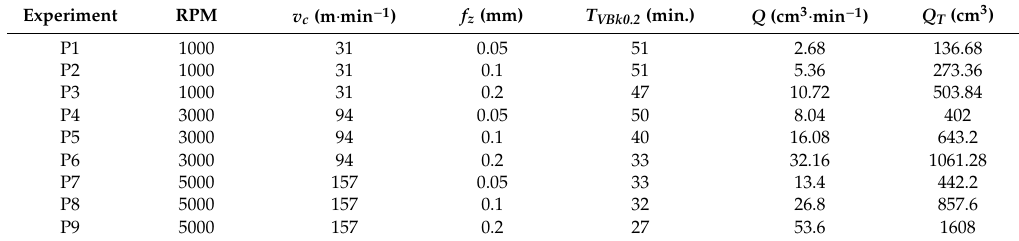
Table 5. Tool life T VBk20 and material removal rate Q for experimental